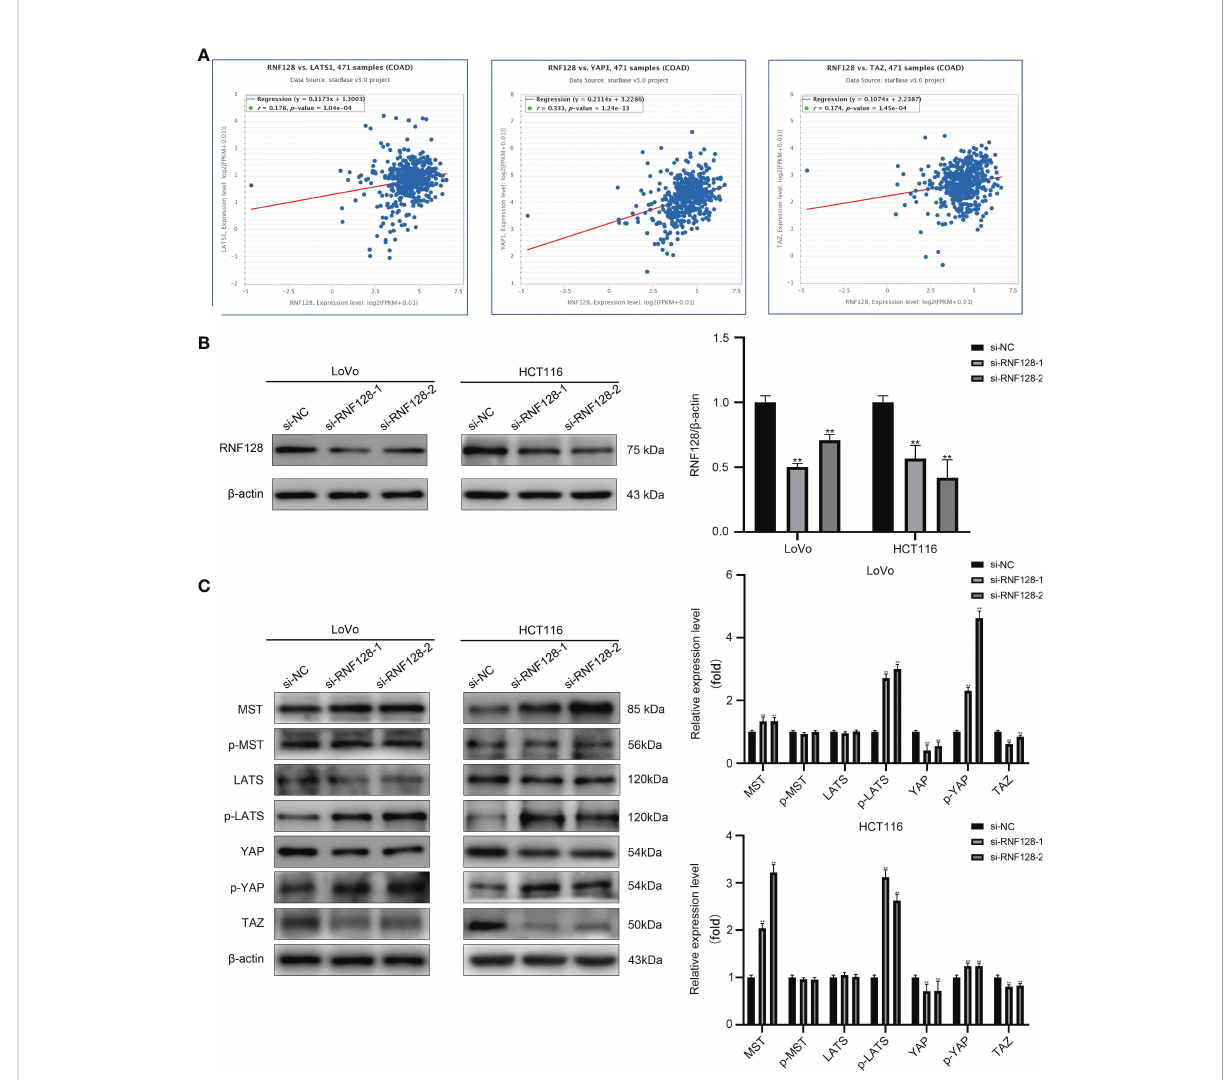
FIGURE 4 RNF128 inhibits the Hippo pathway in colorectal cancer. (A) RNF128 was correlated with Hippo pathway proteins (LATS, YAP, and TAZ) in CRC according to StarBase. (B) RNF128 was downregulated in LoVo and HCT116 cells transfected with si-NC and si-RNF128, as shown by western blot analysis. ** P <0.001. (C) Western blot analysis was used to measure the protein expression of components of the Hippo pathway (MST, p- MST, LATS, p-LATS, YAP, p-YAP, and TAZ) in LoVo and HCT116 cells with RNF128 knockdown. ** P